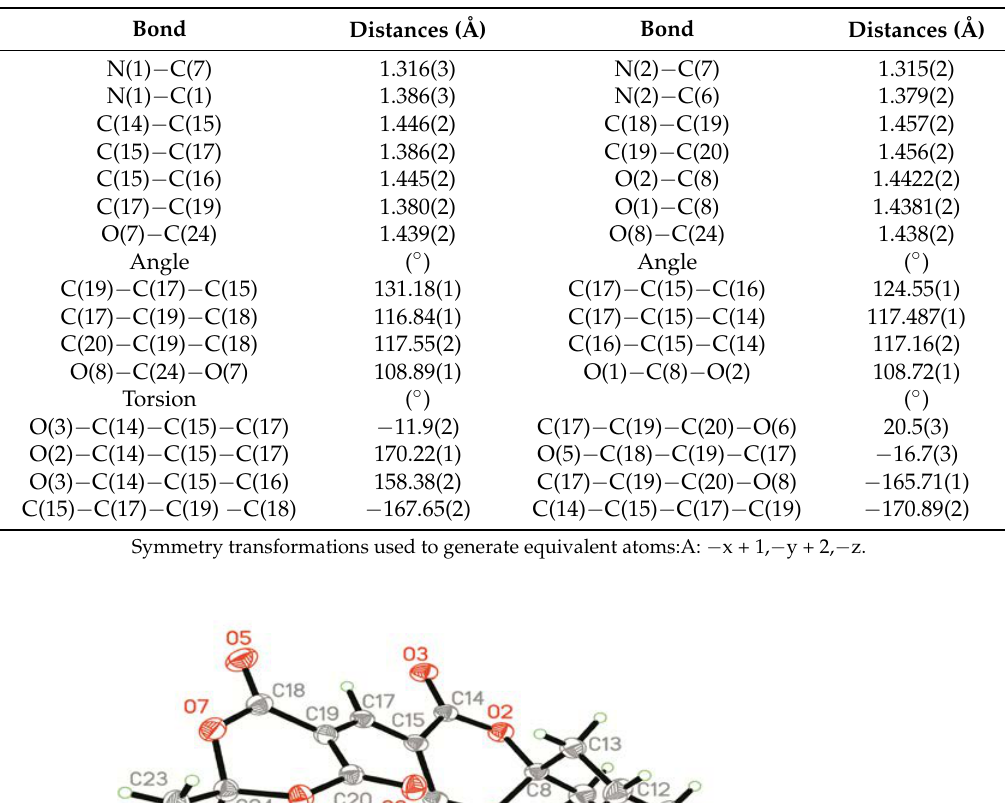
Table 1. Selected molecular structure parameters.